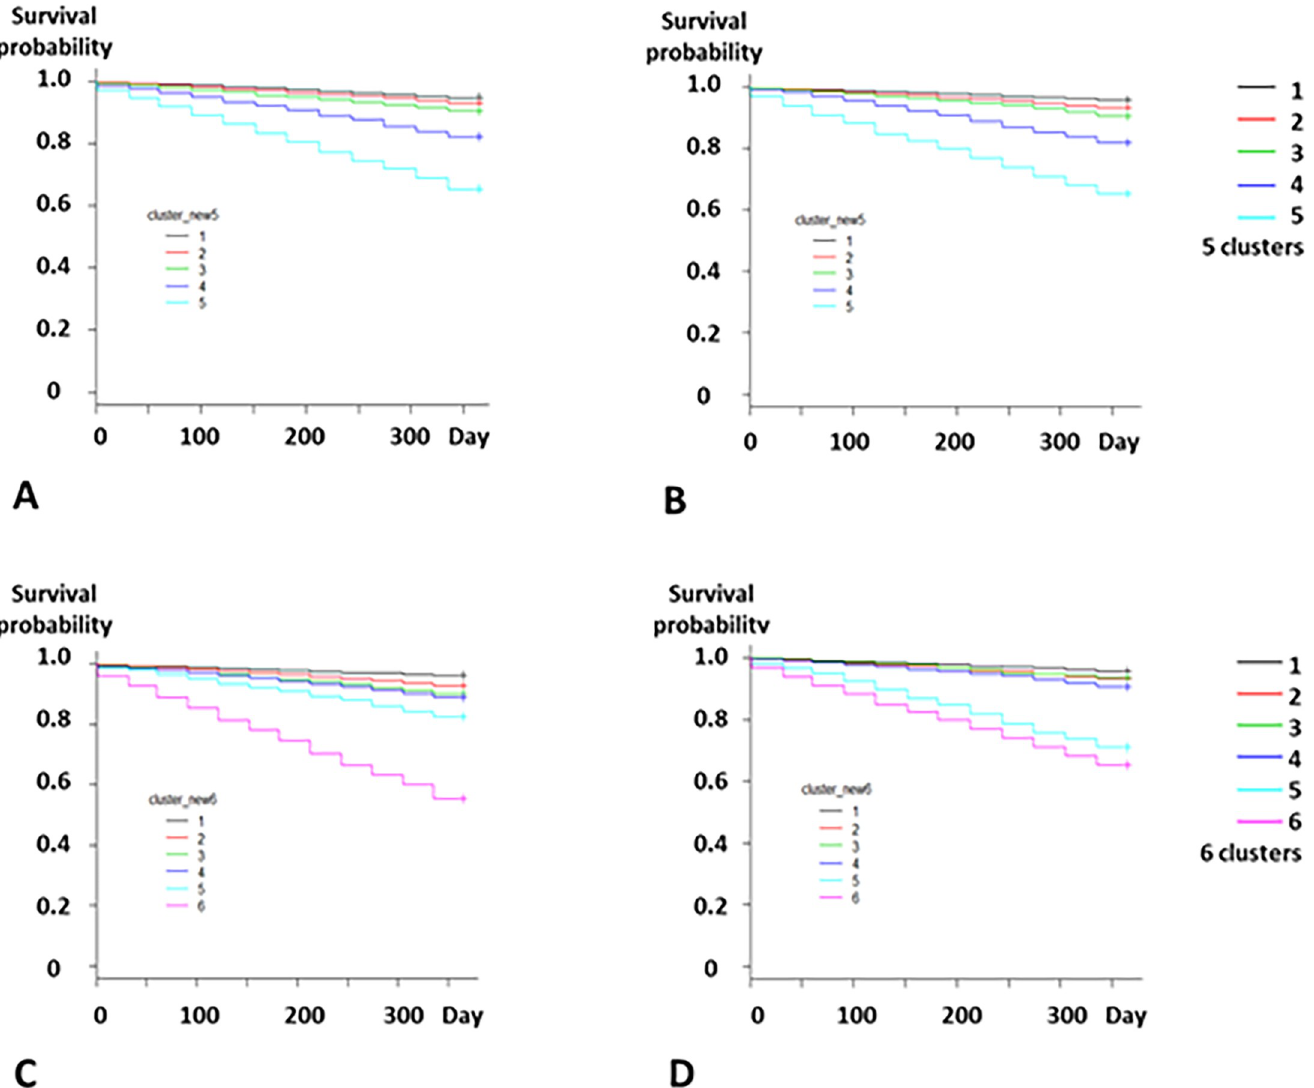
Fig 7. Association between number of clusters and 1-year mortality. A. Five clusters in the development dataset. B. Five clusters in the validation dataset. C. Six clusters in the development dataset. D. Six clusters in the validation dataset. The Kaplan-Meier survival curves show that the low-risk group had the highest survival probability in both